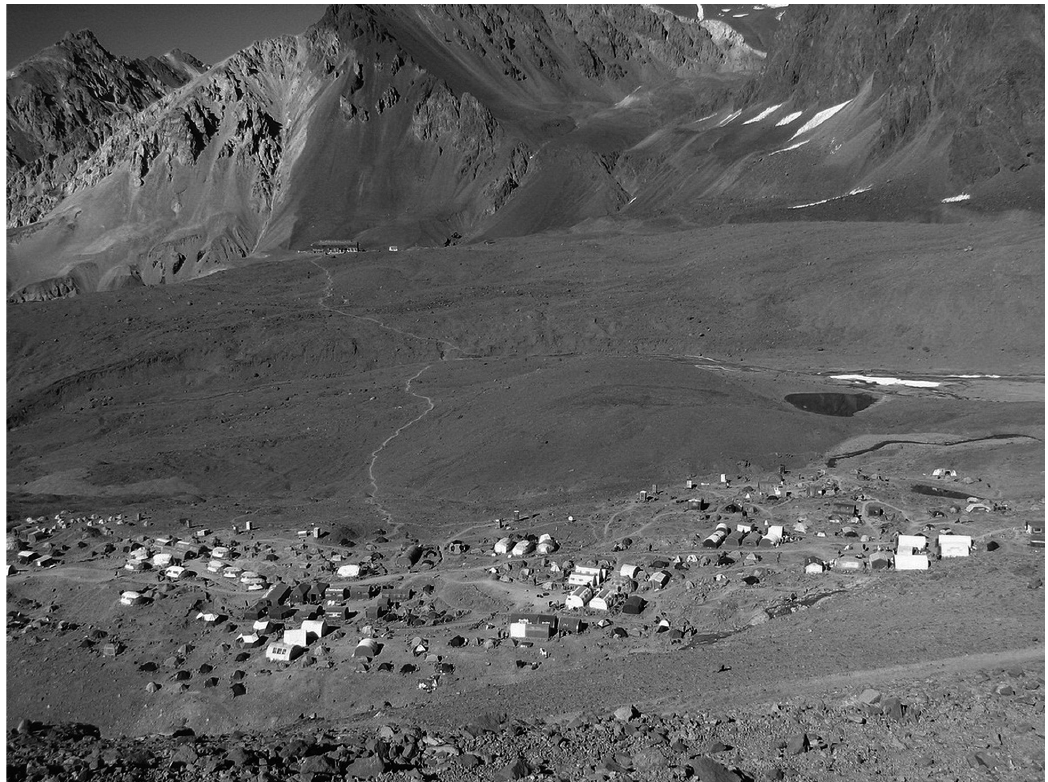
Fig. 3. View of main base Plaza de Mulas from the ascent to the Canada